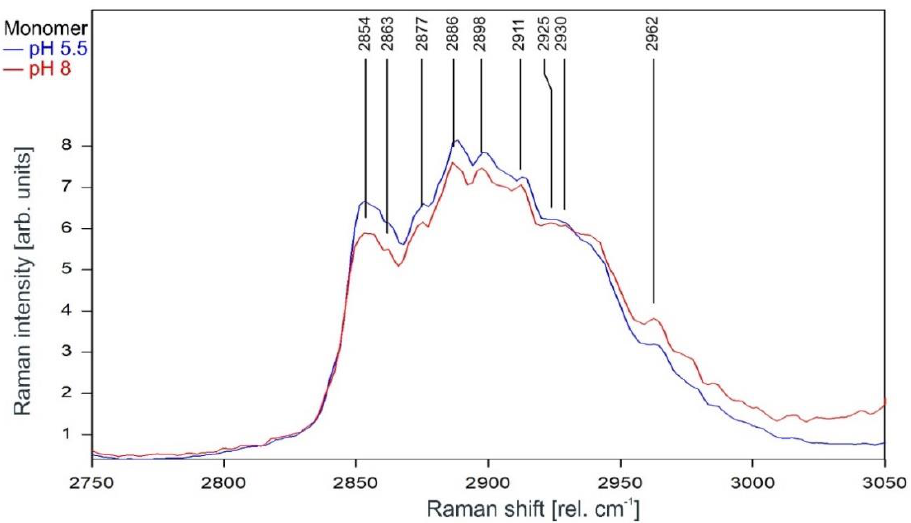
Figure 10. Raman spectrum of KcsA monomer between 2750 and 3050 rel. cm − 1 at pH 5.5 (blue) and pH 8 (red) normalized to the area underneath the spectra between 2800 and 3000 rel. cm − 1 for clarity. Raman lines shared by the spectra are marked in black.